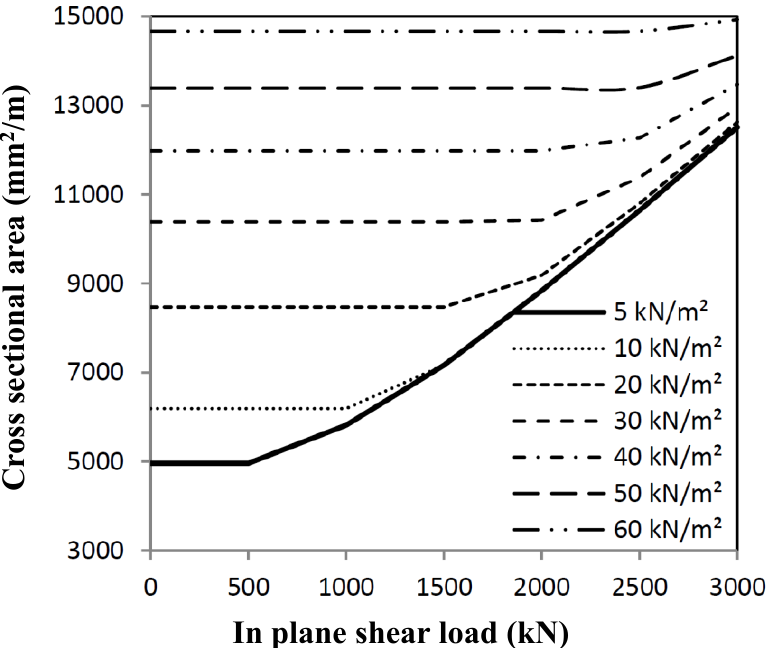
Figure 6. Minimum cross-sectional area for out-of-plane loading dependent on the shear load.